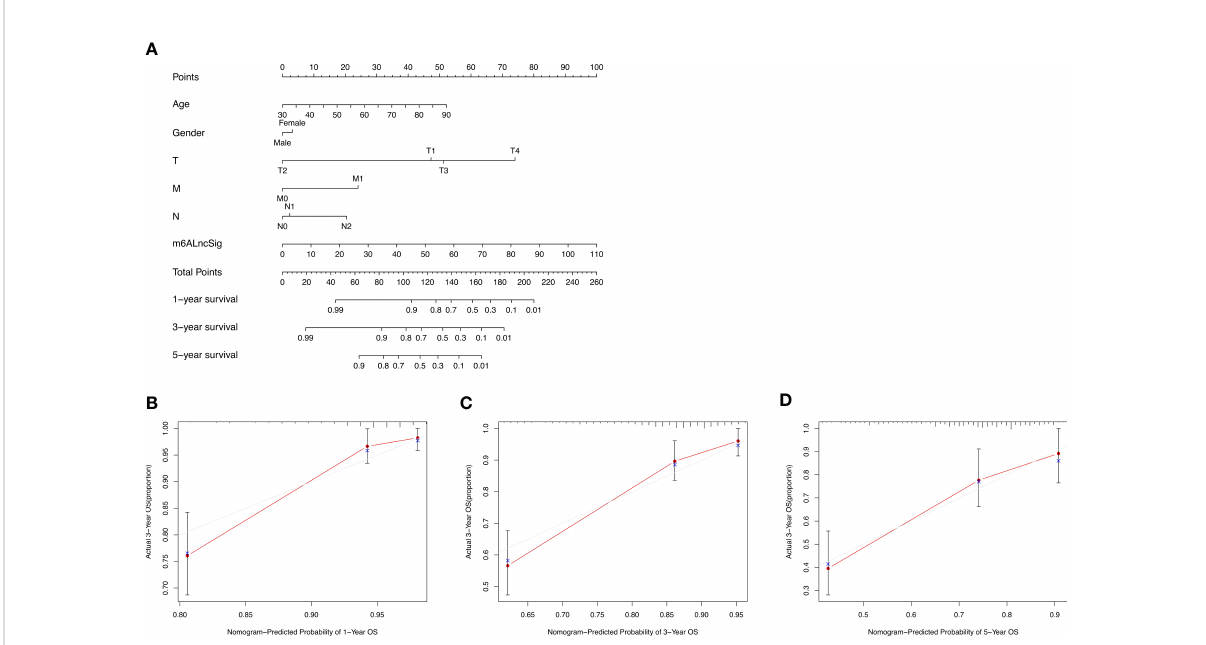
FIGURE 11 Nomogram and performance evaluation. (A) Nomogram predicting 1-, 3- and 5-year OS for patients with COAD. (B – D) Calibration plot of the nomogram for 1-, 3- and 5-year